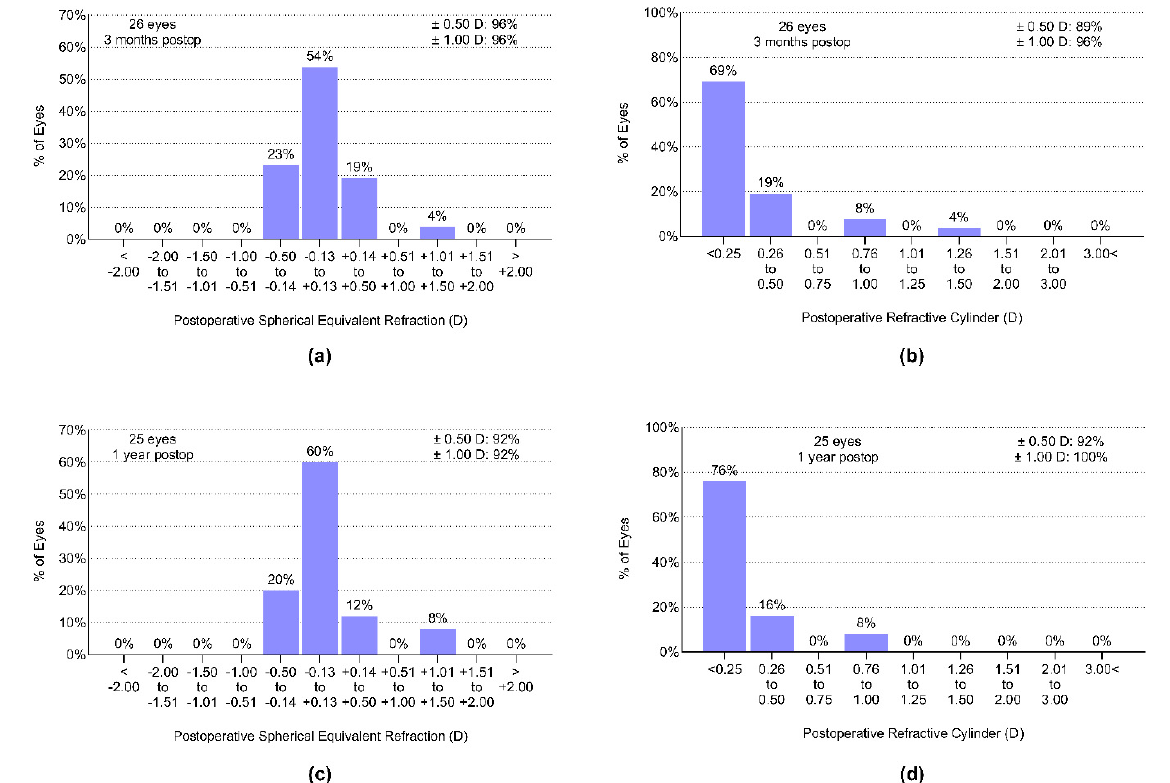
Figure 1. Spherical equivalent refraction and residual refractive cylindric refraction measured three months ( a , b ) and one year ( c , d ) postoperatively.